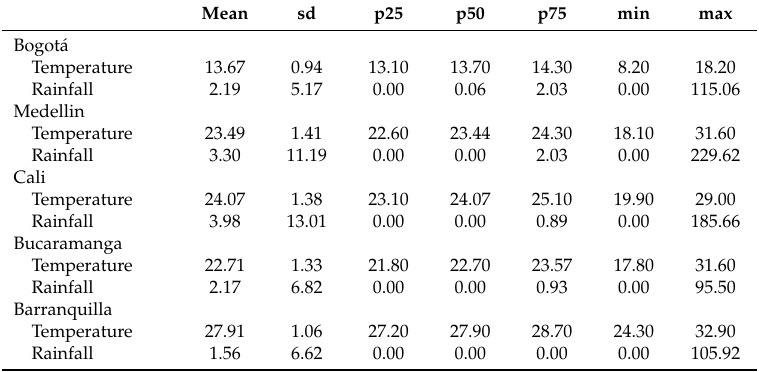
Table 1. Distribution of the daily weather variables for the five main cities of Colombia.